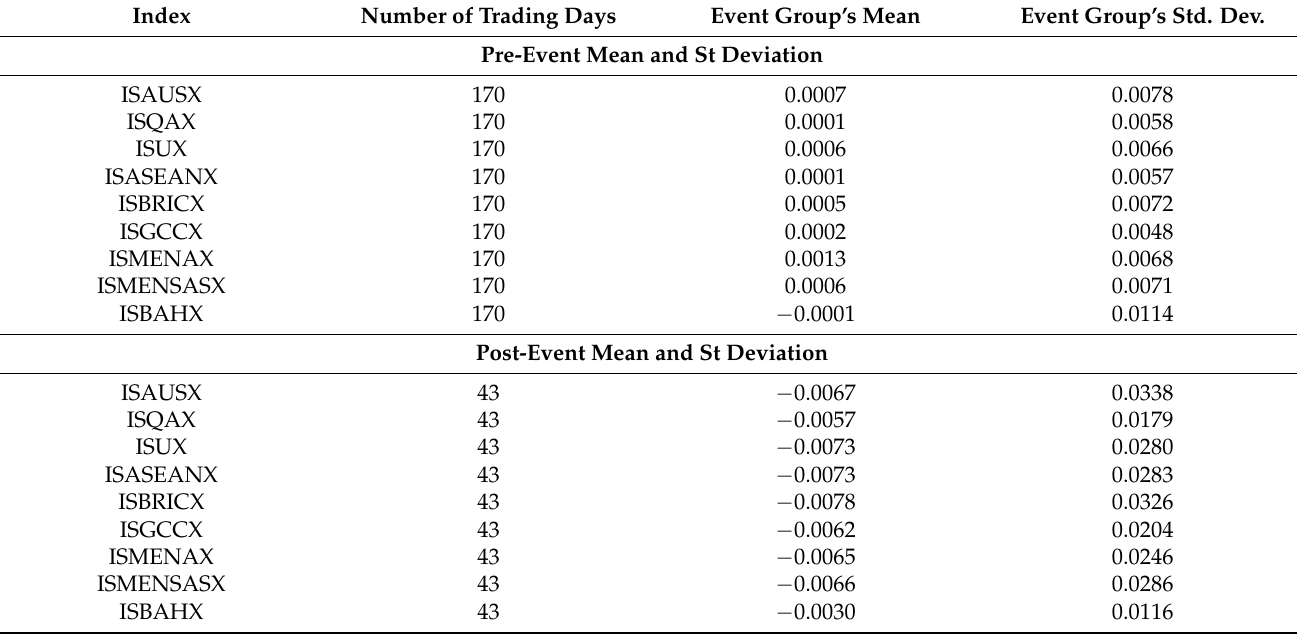
Table 2. Differences in mean returns of sample